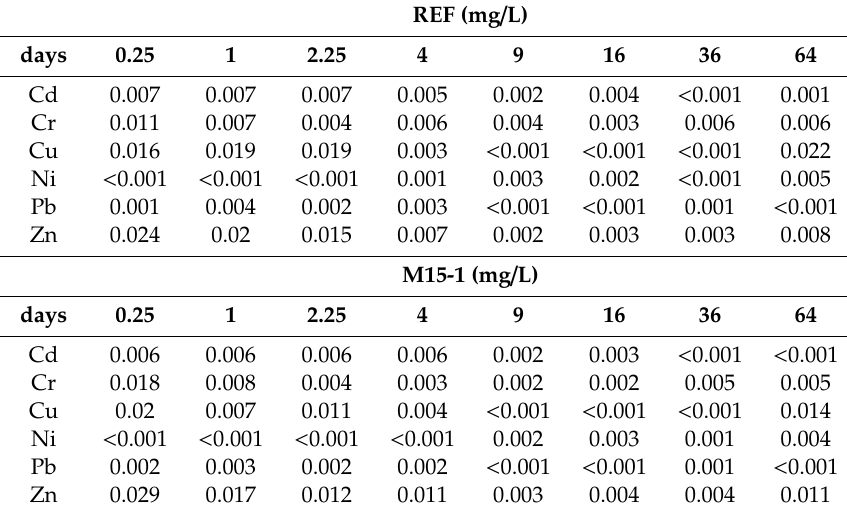
Table A1. Results of the leach testing of the monolithic samples, by time